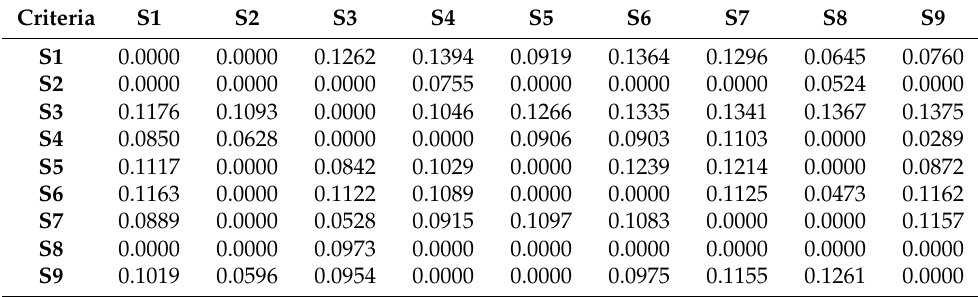
Table 3. The normalized matrix.